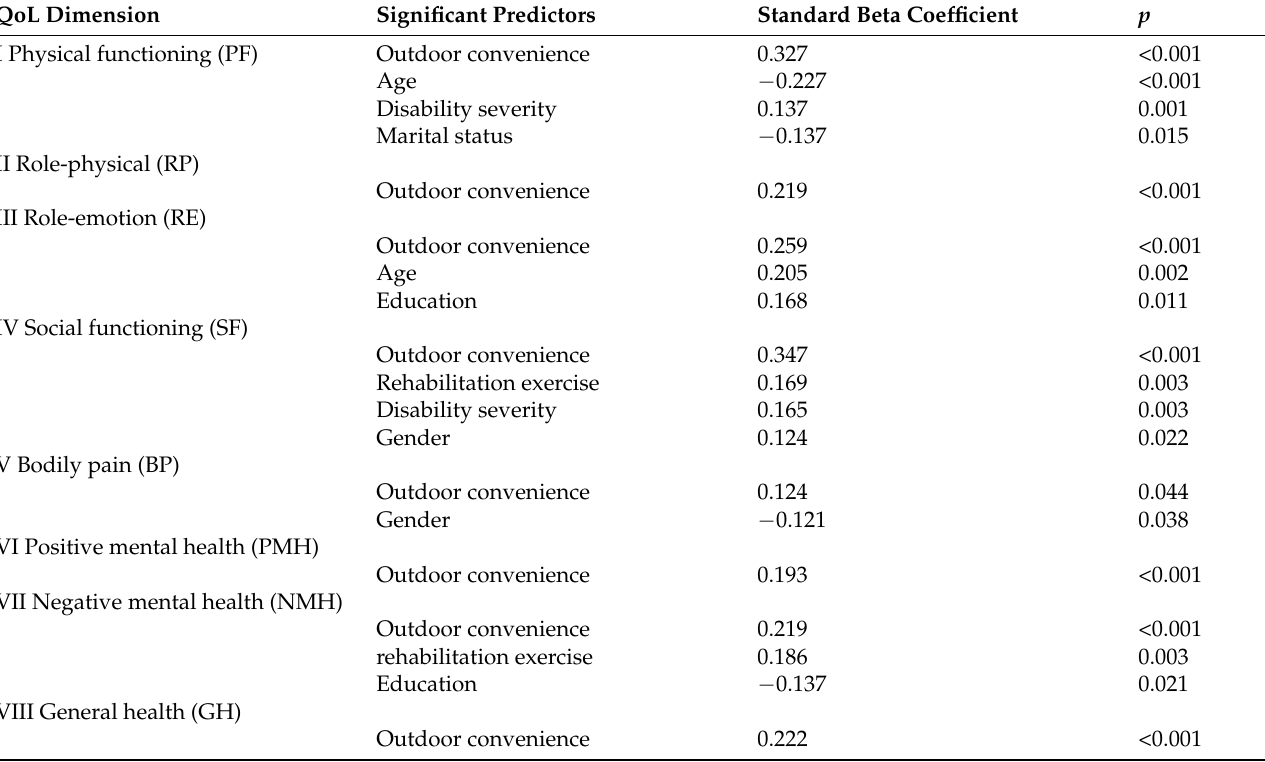
Table 4. Backward regression results indicate factors influencing SF-36